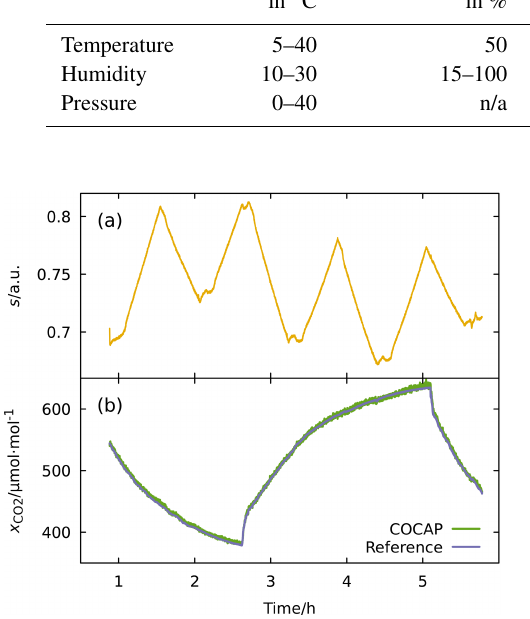
Figure 6. (a) Normalised infrared signal of COCAP’s CO 2 sen- sor under changing ambient conditions. This is a subset of the data shown in Fig. 4d. (b) x CO calculated using the calibration curve 2 (Eqs. 4 and 5) compared to the measurements of a reference anal- yser (Picarro G2401). The x CO signal is recovered despite strong 2 influences from changing